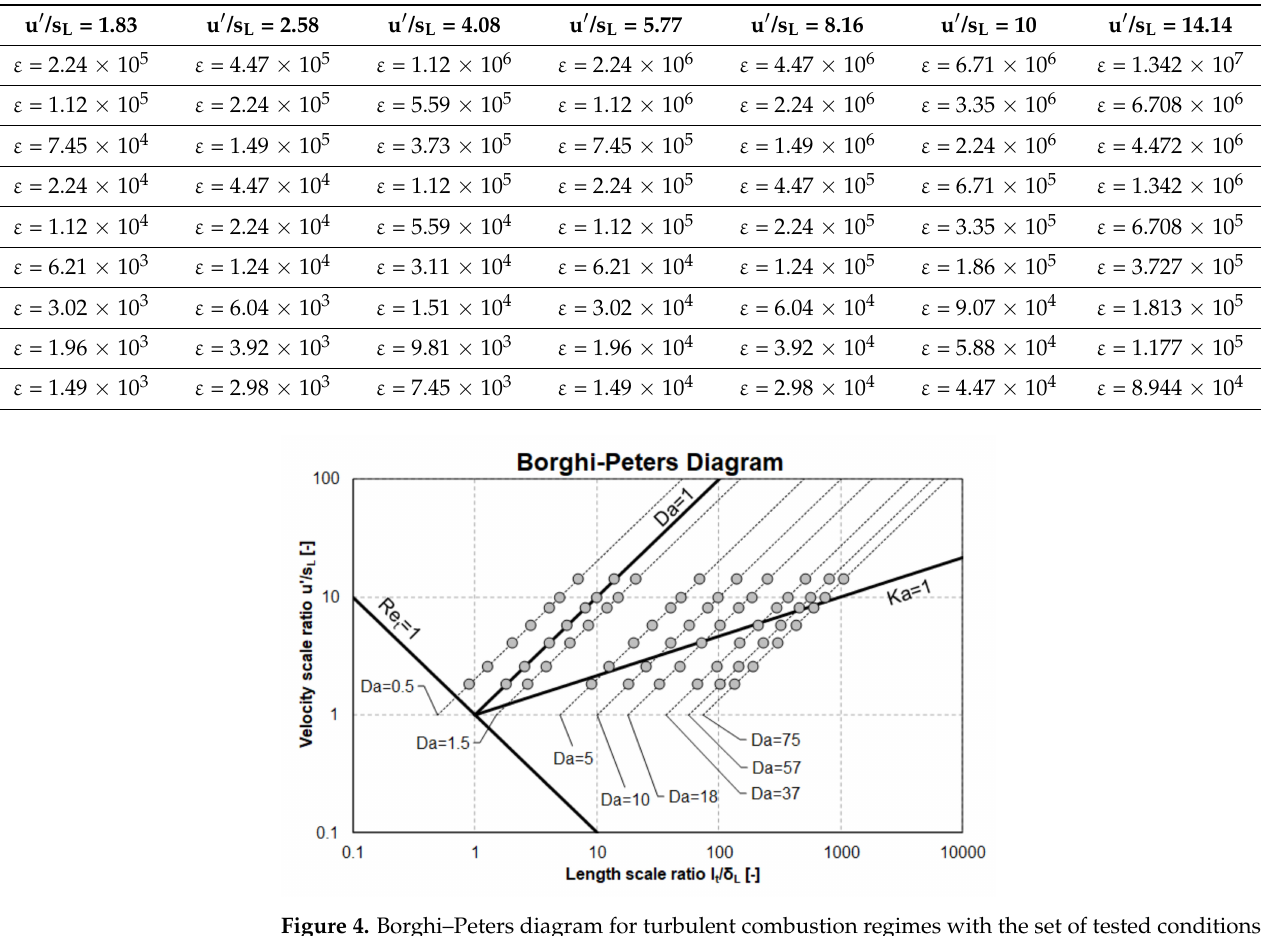
Table 1. Set of ε